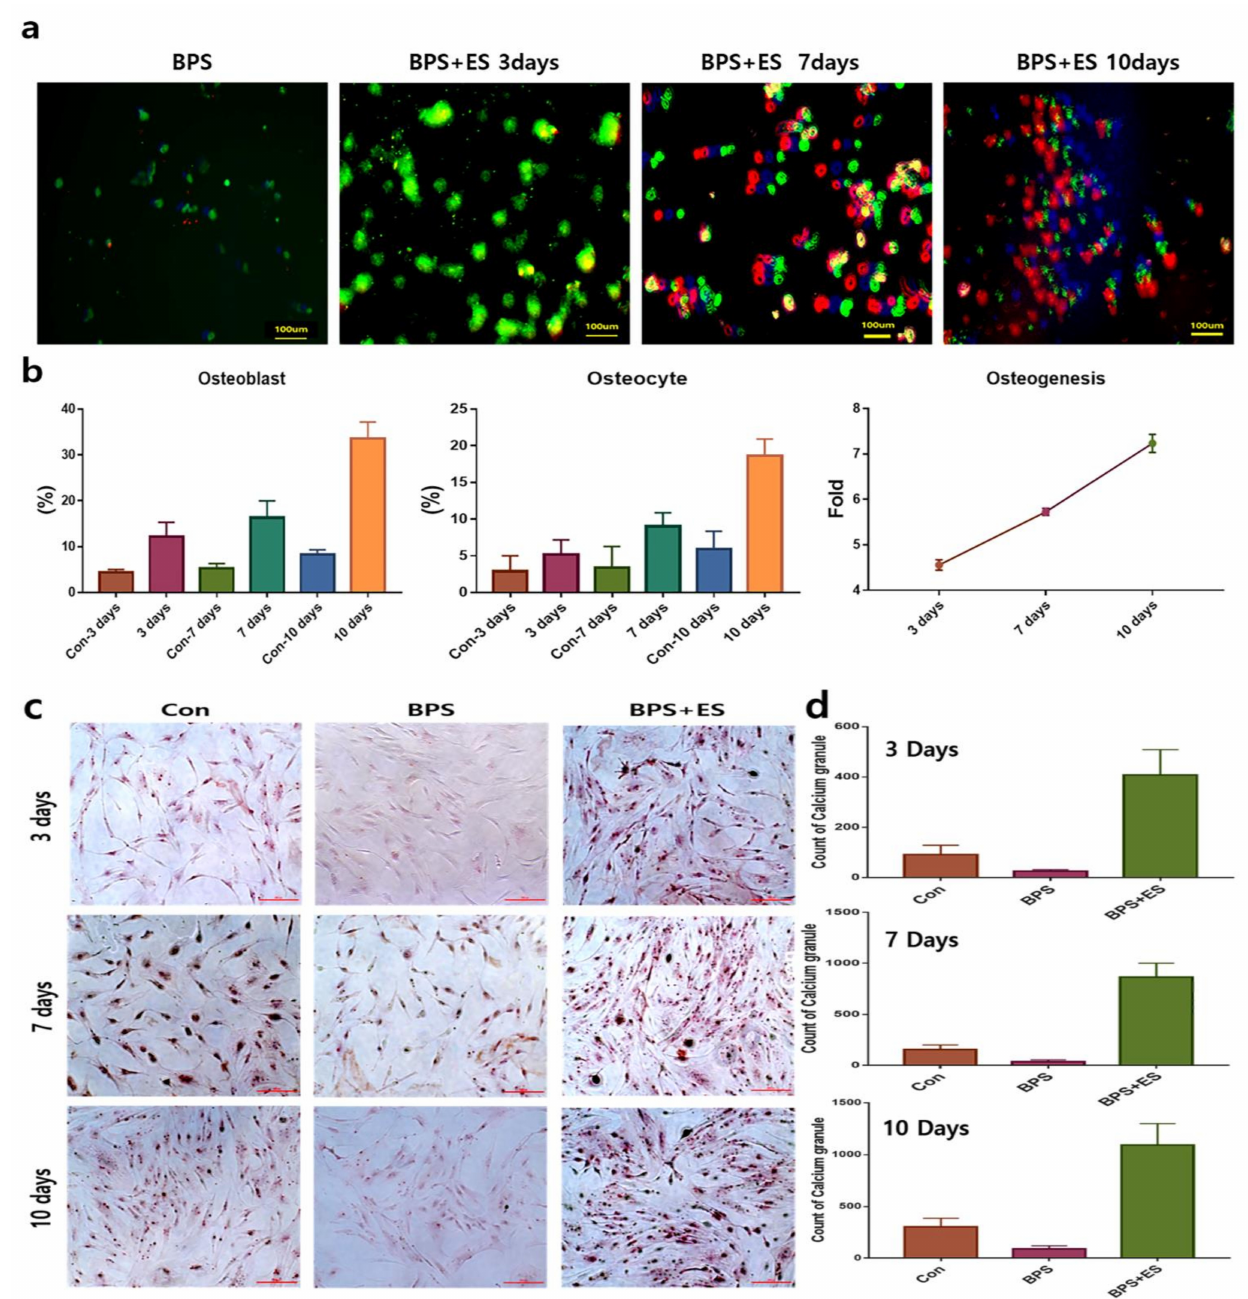
Figure 7. Image analysis for differentiated osteoblasts and osteocytes of adipose-derived stem cells (ASCs) cultured in the conditioned media. ( a ) Images indicating stained cells for osteoponin, osteocalcin, and sclerostin, detected using fluorescence-labeled antibodies and a microscope. Green; osteocalcin, blue: osteoponin, red; sclerostin. ( b ) Relative fold changes for the corresponding stained cell counts. ( c ) ASCs staining by using alizarin Red S stain under various conditions. ( d ) Results from the counting of calcium granules in ASCs using software, NIS-Elemnets V5.11. Relative fold changes between BPS and BPS+ES. BPS+ES represents that ASCs were exposed to BPS after treatment using ES. The conditioned medium (BPS) contained the supernatant from the fibroblast cells exposed to benzo(a)pyrene. The conditioned medium (ES) contained the supernatant from the fibroblast cells exposed to the extract. Con; Control, ( p < 0.05, n =